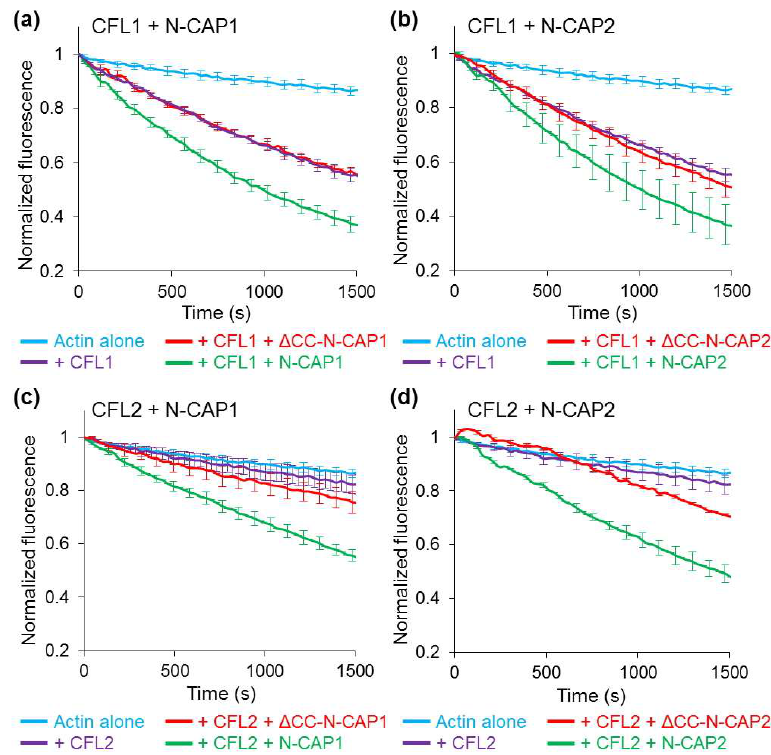
Figure 5. Effects of N-CAP oligomers on cofilin-mediated F-actin disassembly in bulk pyrene–actin depolymerization assays. Depolymerization of preassembled pyrene-labeled (10%) F-actin from the pointed ends (in the presence of CapZ) was initiated by the addition of a G-actin-sequestering drug